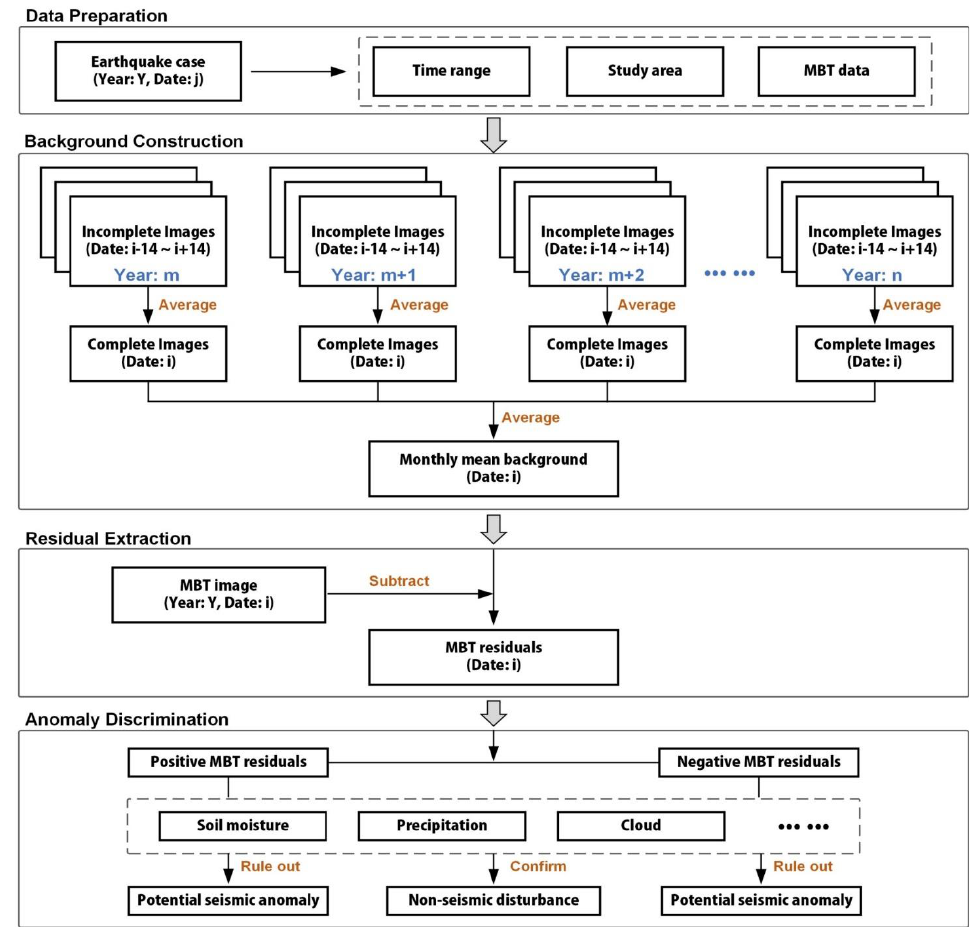
Figure 2. Analysis methodology of seismic microwave radiation anomaly based on monthly mean background of MBT.